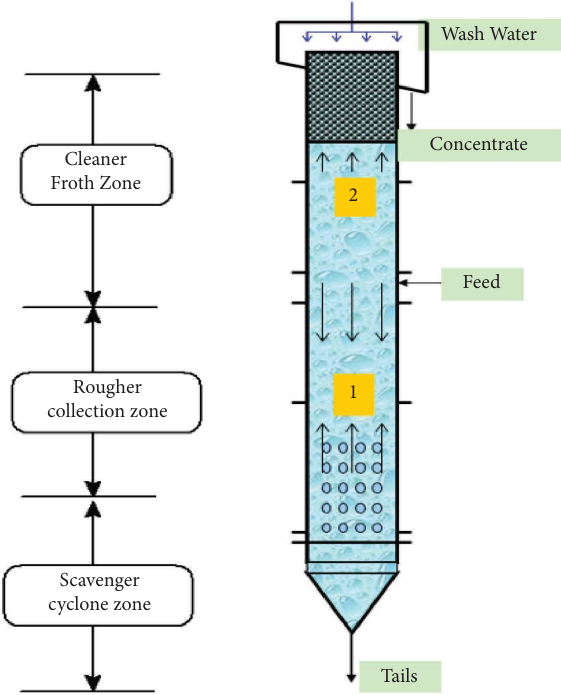
Figure 1: Schematic diagram of fotation